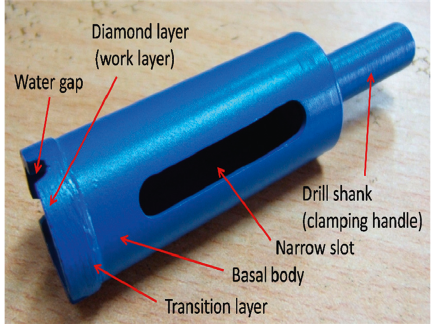
Figure 1: The sintering diamond core